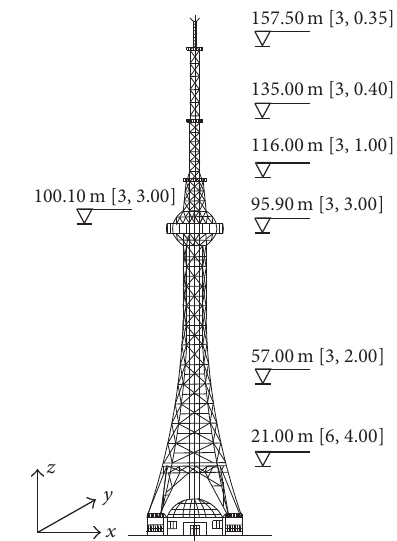
Figure 3: Scheme of TV Tower and location of the gimbal gyro-